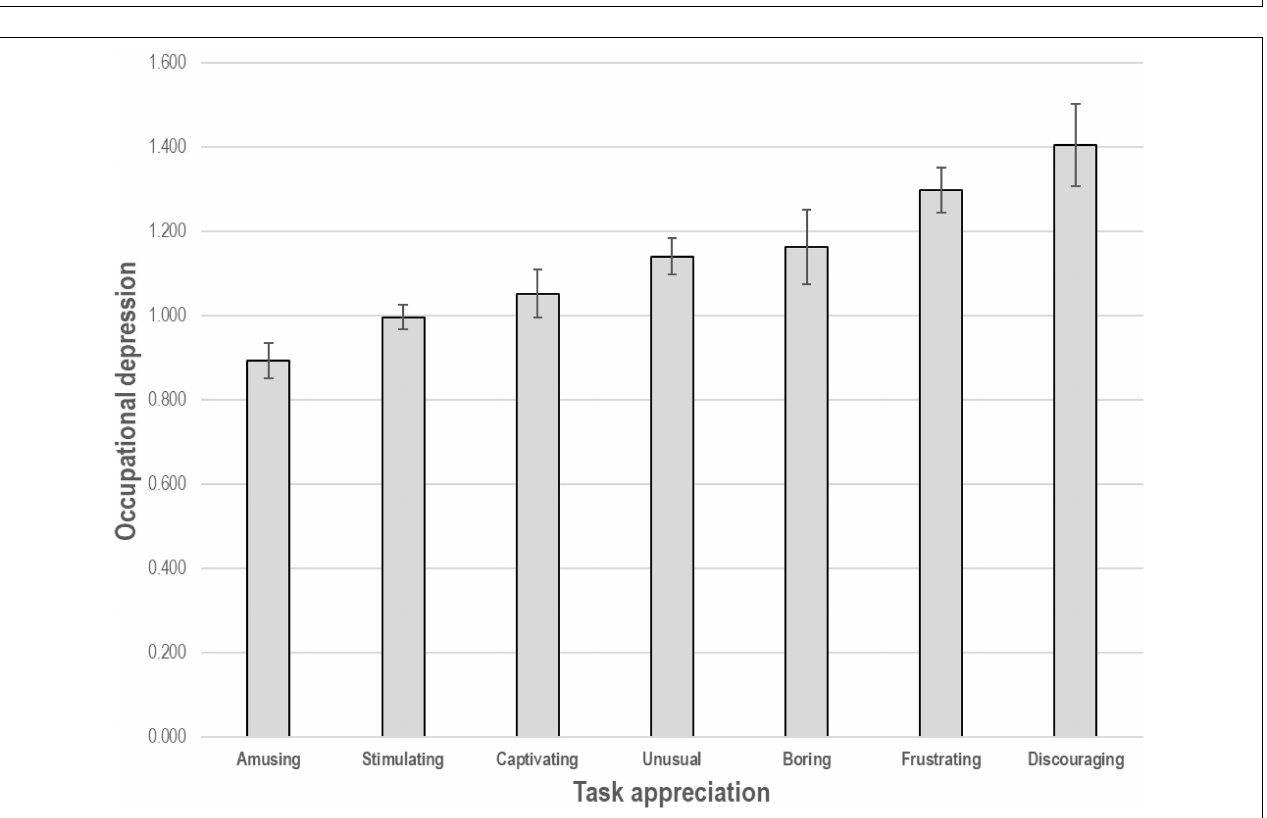
FIGURE 2 | Summary of the study procedure (RAPMs: Raven’s Advanced Progressive Matrices; ODI: Occupational Depression Inventory).